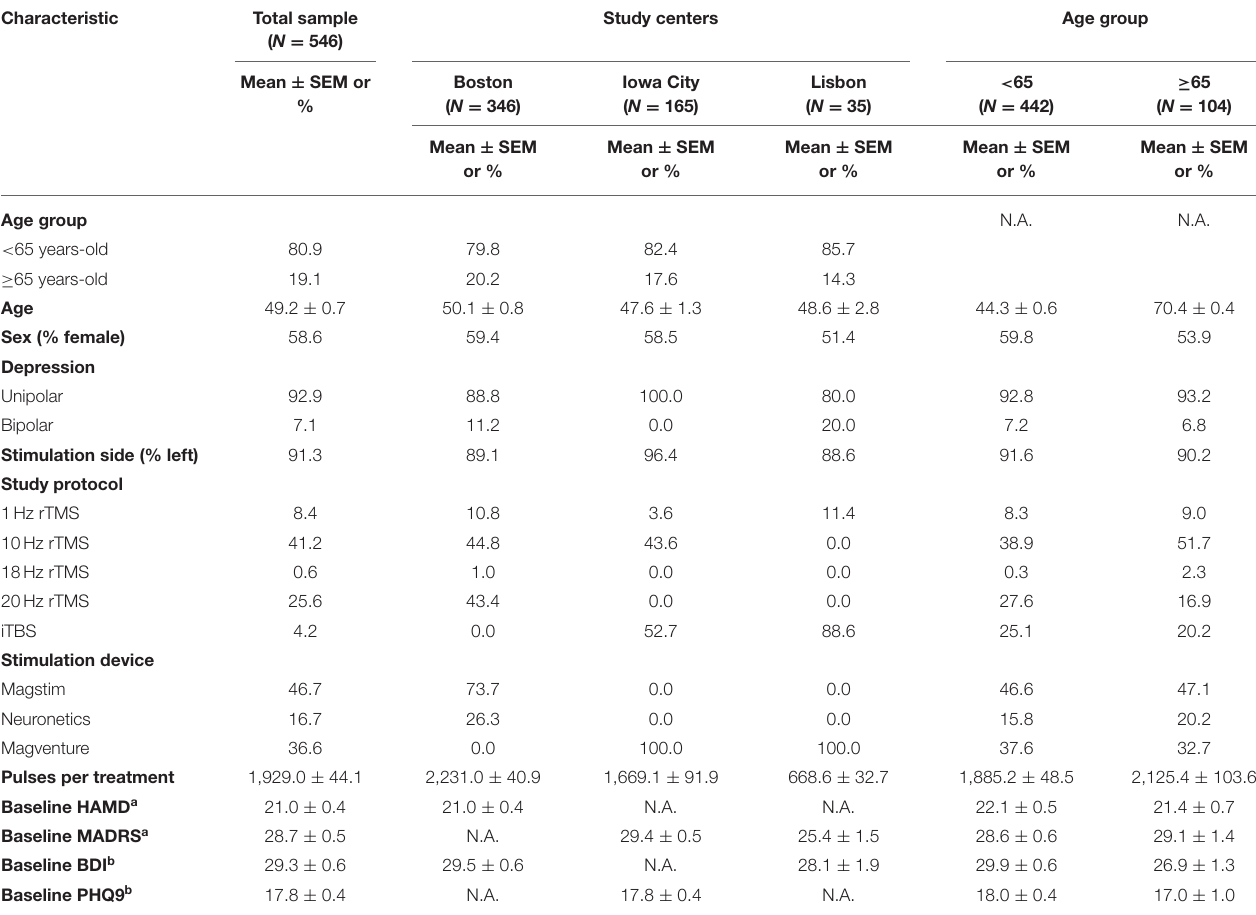
TABLE 1 | Demographic and clinical characteristics of study